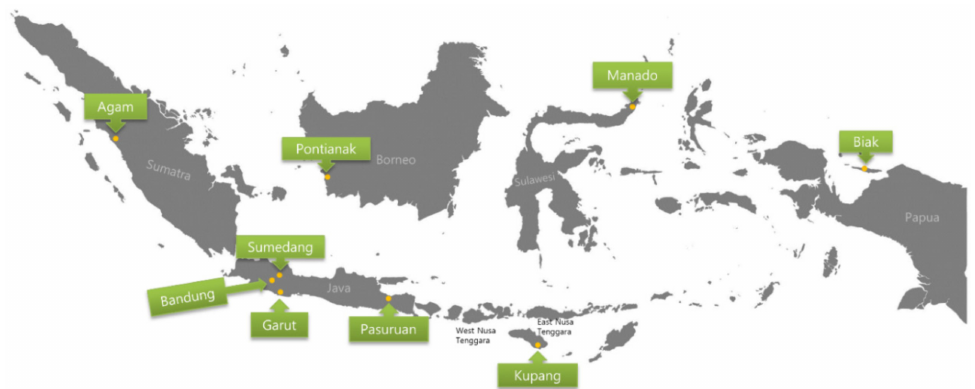
Figure 1. Map of LAPAN (Indonesia National Institute of Aeronautics and Space) observatories in